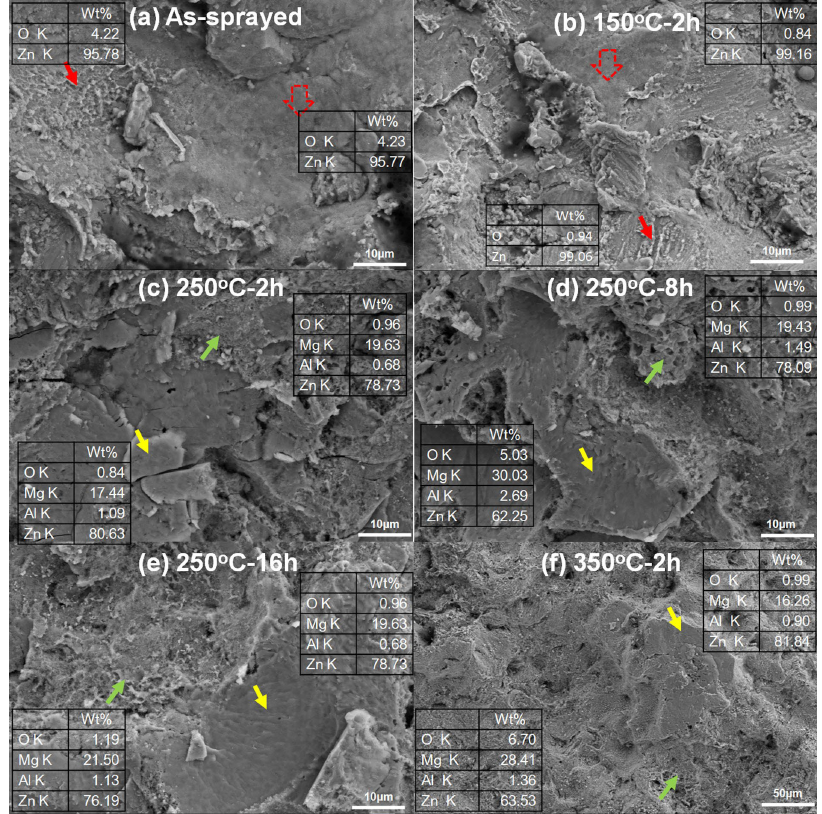
Figure 6. Morphologies of fractured surfaces of Zn coatings after different heating conditions.